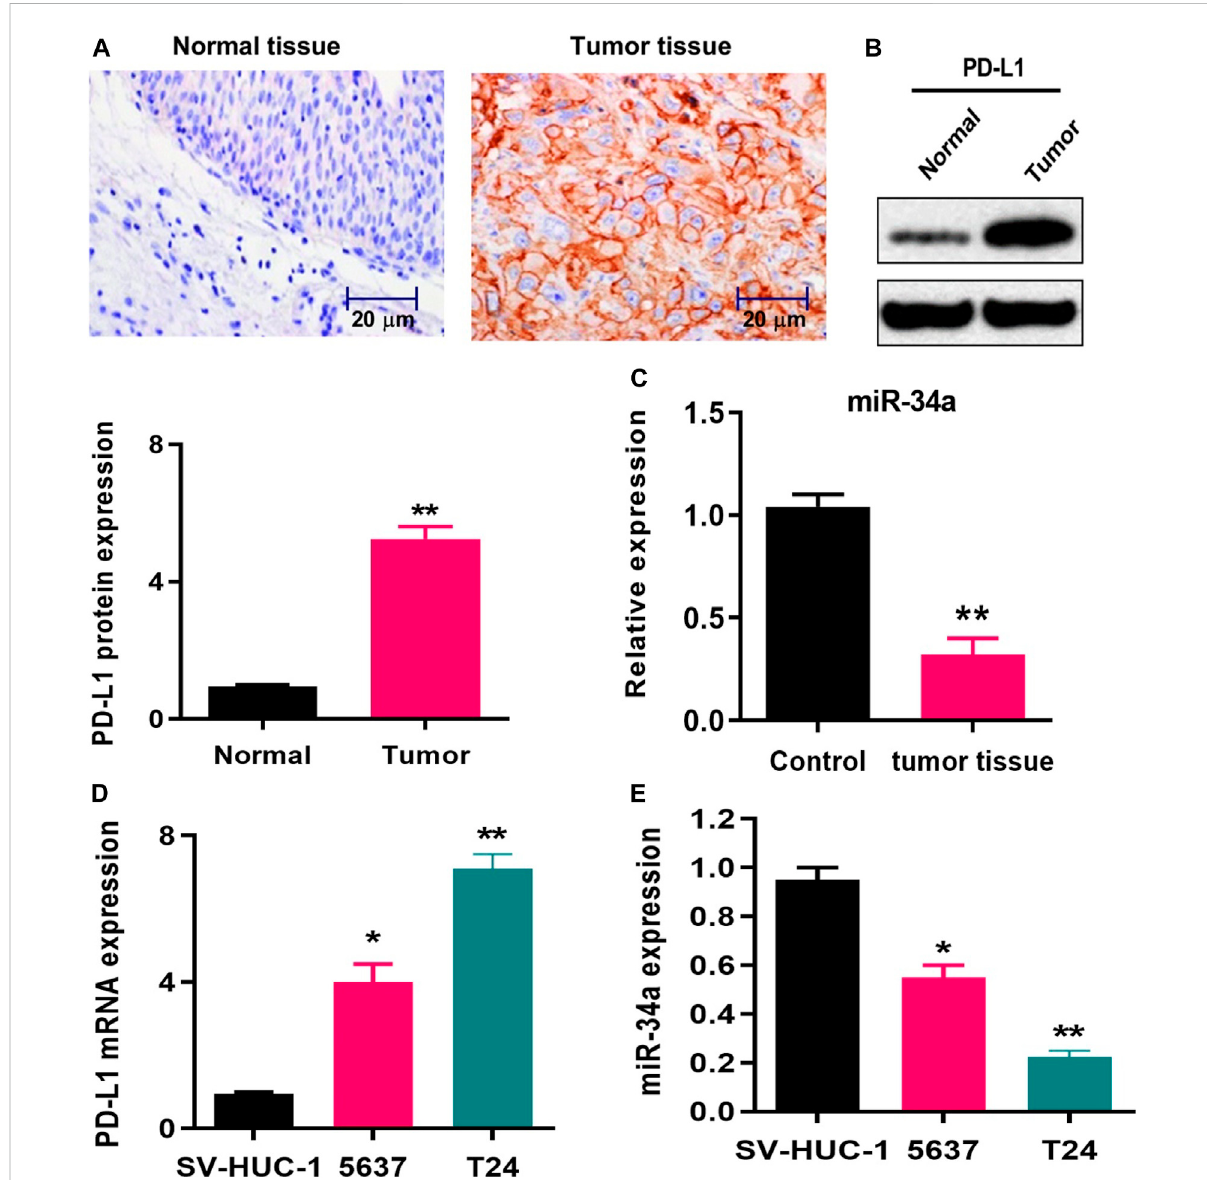
Expression of PD-L1 and miR-34a in bladder cancer. (A) Immunohistochemical staining of PD-L1 in 32 bladder tumors and adjacent normal bladdertissues(scalebars:20 µm). (B) DeterminationofPD-L1proteinlevelin32tumorandadjacentnormalbladdertissuespecimensusingwestern blotting. (C) Determining miR-34a expression in 32 tumor and adjacent normal bladder tissue specimens using q-RT-PCR. (D,E) Measuring PD-L1 and miR-34a expression in T24, 5637, and SV-HUC-1 by q-RT-PCR. All quanti fi cation levels were normalized to GAPDH and U6. (* p <